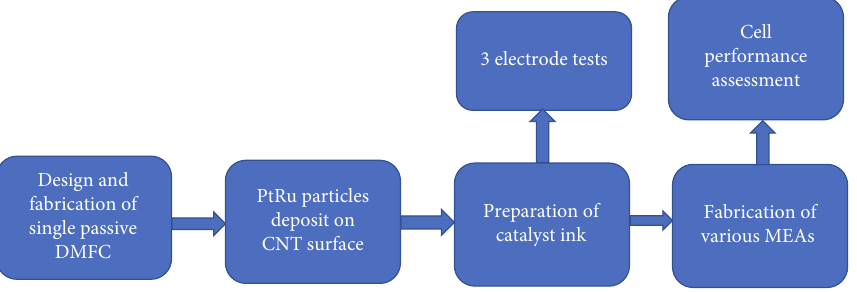
Figure 1: Schematic view of the methodology.